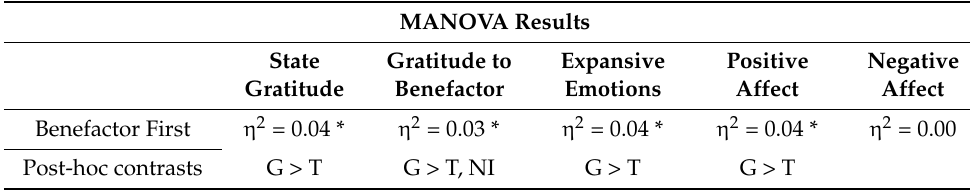
Table 3. Hypothesis 3 and 4: Attitude accessibility predicting outcomes.